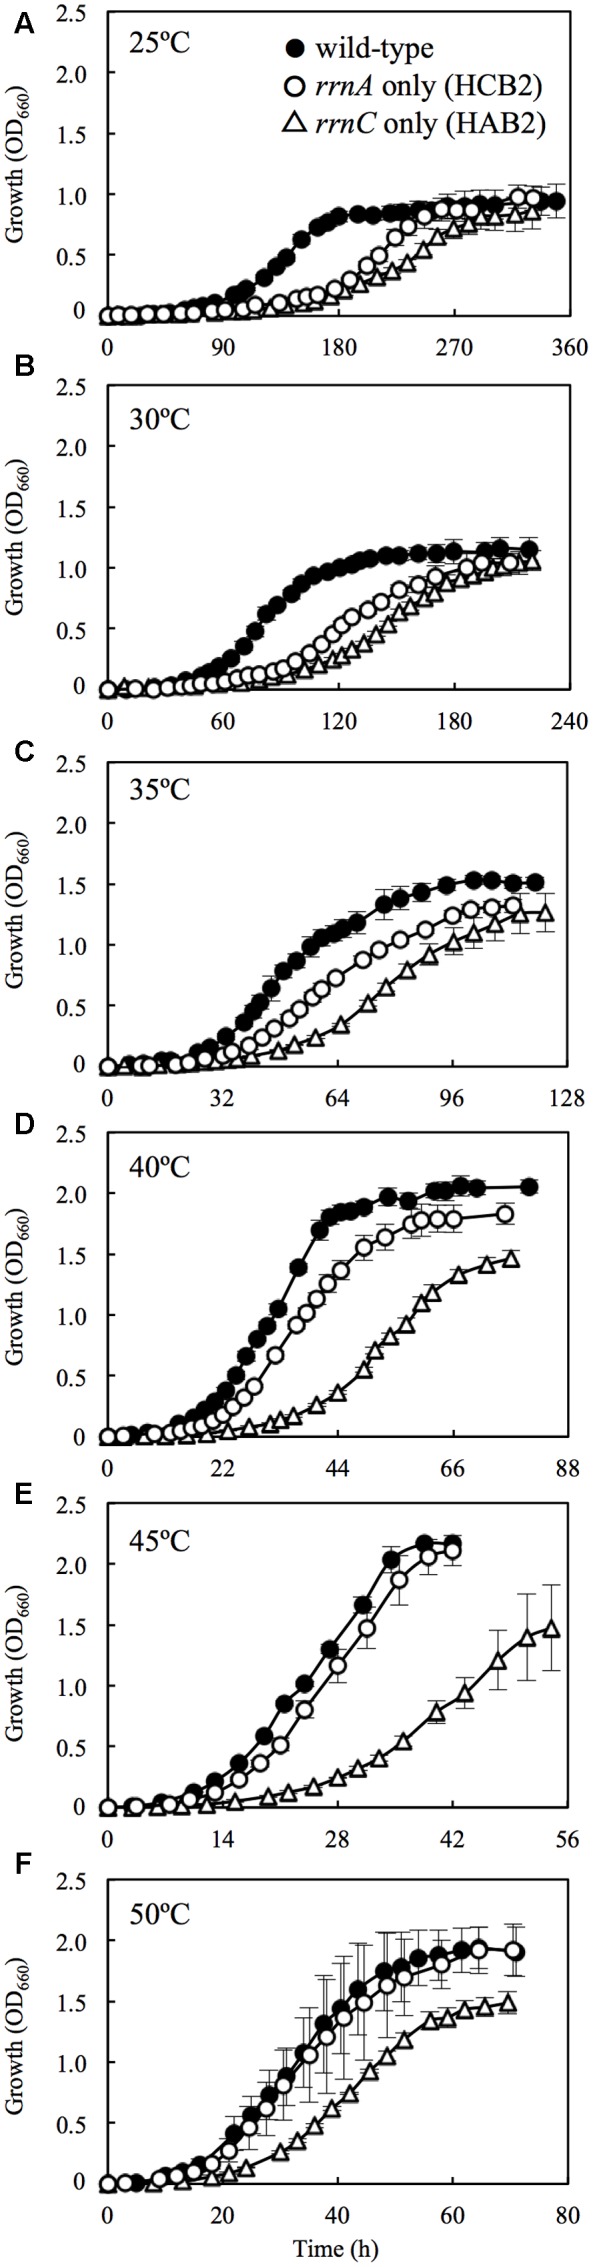
Growth curves for wild-type H. hispanica and the rRNA operon double-mutant strains at 25 (A), 30 (B), 35 (C), 40 (D), 45 (E), and 50°C (F). Error bars denote standard deviation of mean values for quadruplicate or quintuplicate measurements.